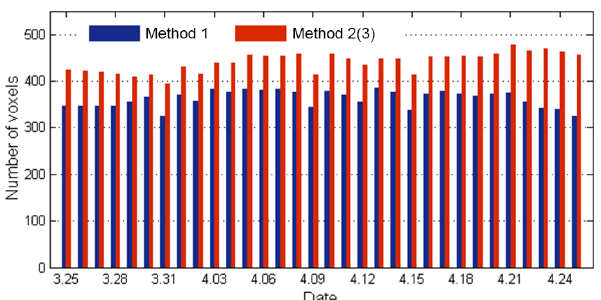
Figure 4. The number of voxels crossed by rays for different meth- ods in the